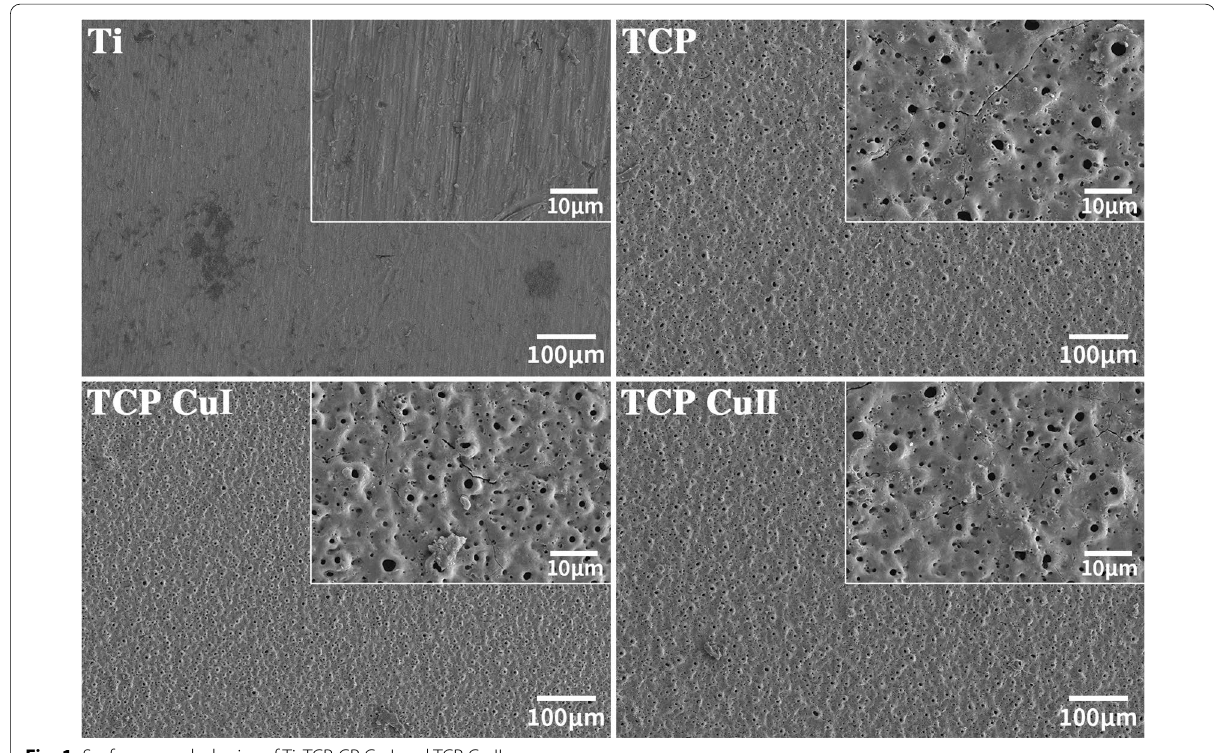
Fig. 1 Surface morphologies of Ti, TCP, CP Cu I and TCP Cu